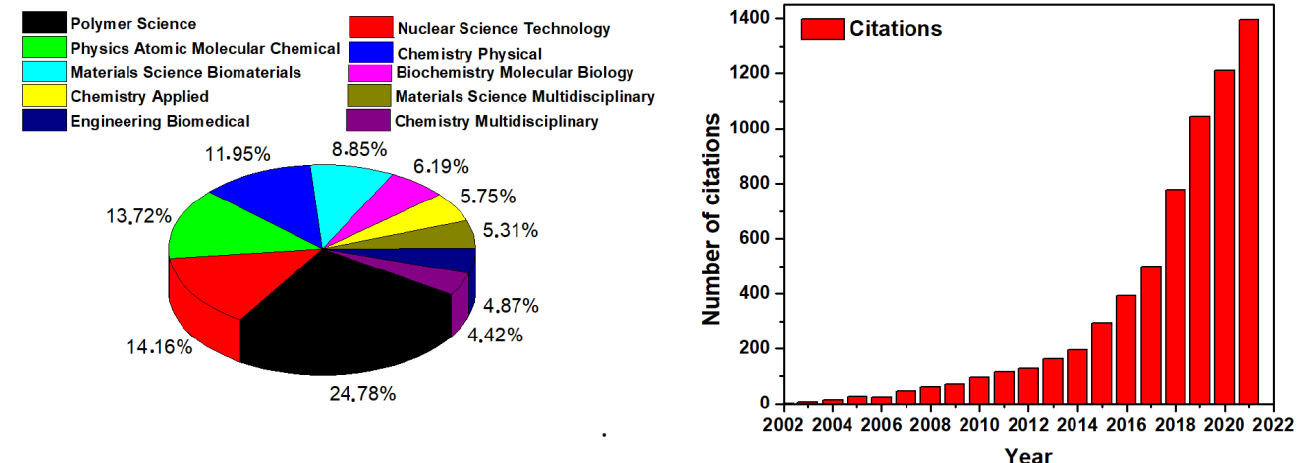
Figure 1. Papers published on hydrogel wound dressings prepared by ionizing radiation in various disciplines and the number of citations per year.